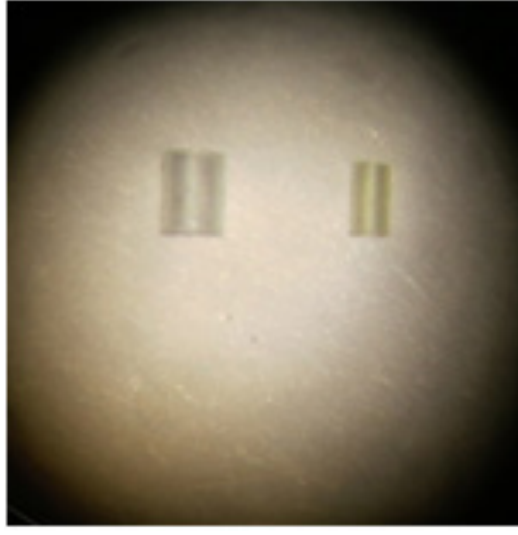
Fig. 1 - Cuffs. The left cuff is for external jugular vein (EJV) eversion, and the right cuff is for carotid artery (CA) eversion.